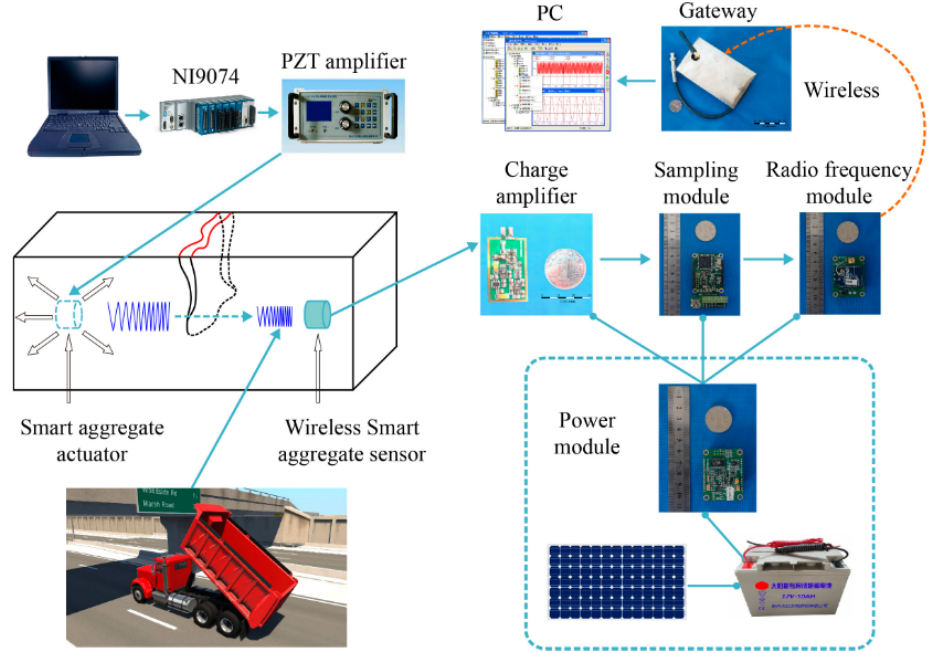
Figure 9. System setup and signal flow of the SHM system [142]. Reprinted under the Creative Commons (CC) License (CC BY 4.0).